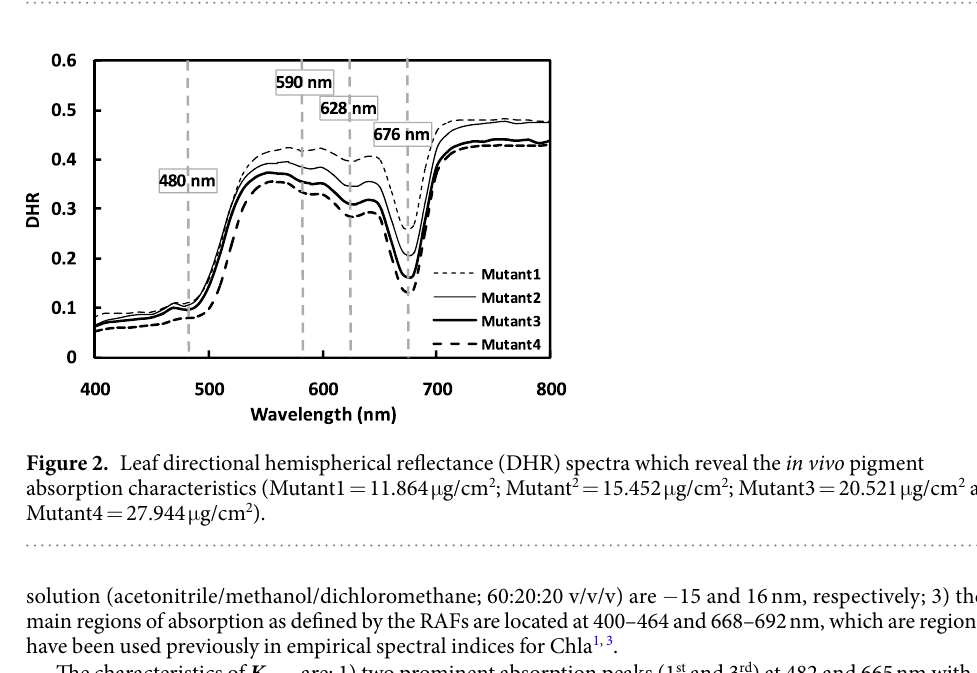
Figure 1. Spectral characteristics of the determined PROSPECT-5 (P5, solid line) and PROSPECT-MP (PMP, dotted line) parameters in vivo leaf. ( a ) show for Chla absorption coefficient ( K coefficient ( K ); ( c ) for K ; ( d ) for leaf baseline absorption coefficient ( K Chlb Cars index ( ¯ m ). la